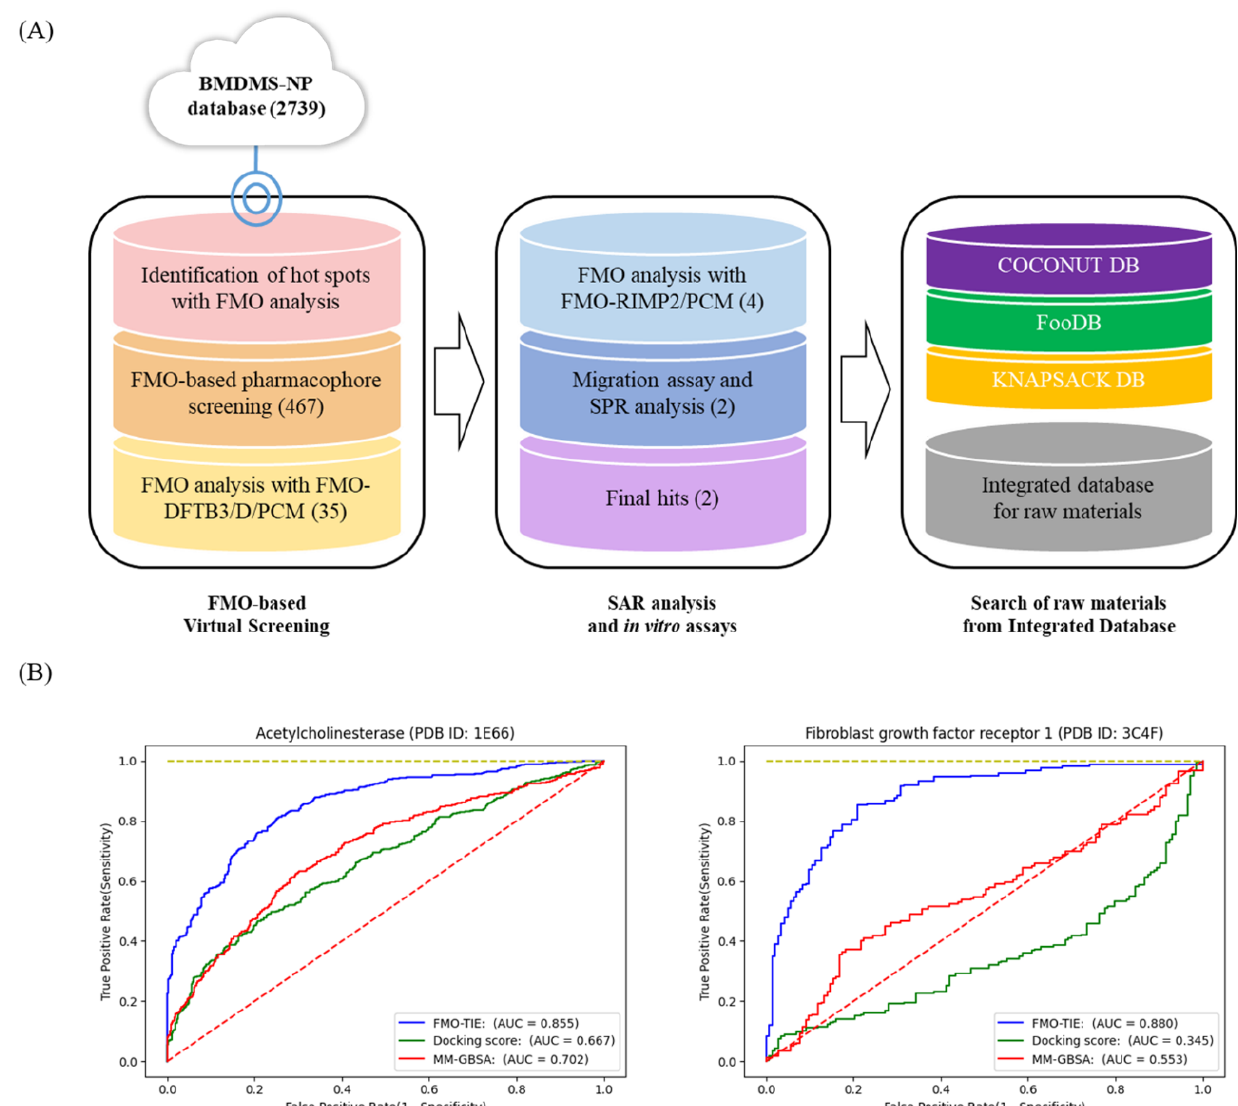
Figure 1. FMO-based workflow and scoring function evaluation in FMO-based virtual screening. ( A ) FMO-based workflow to discover natural product inhibitors of MMP-9 and find their respective raw material information. ( B ) Evaluation of the scoring function in FMO-based virtual screening in the two benchmarking sets.